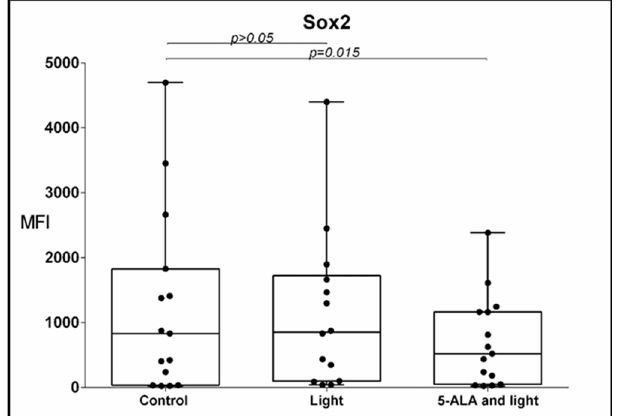
Figure 5. Boxplot showing the change in the percentage of Sox2-positive GB-MSCs across paired samples of control cell cultures, cell cultures treated with light only, and cell cultures exposed to 5-ALA and light. The Sox2 expression was evaluated using multi-color flow cytometry, and every dot on the box plot represents the percentage values of all Sox2-positive GBM-MSCs in that particular cell culture.